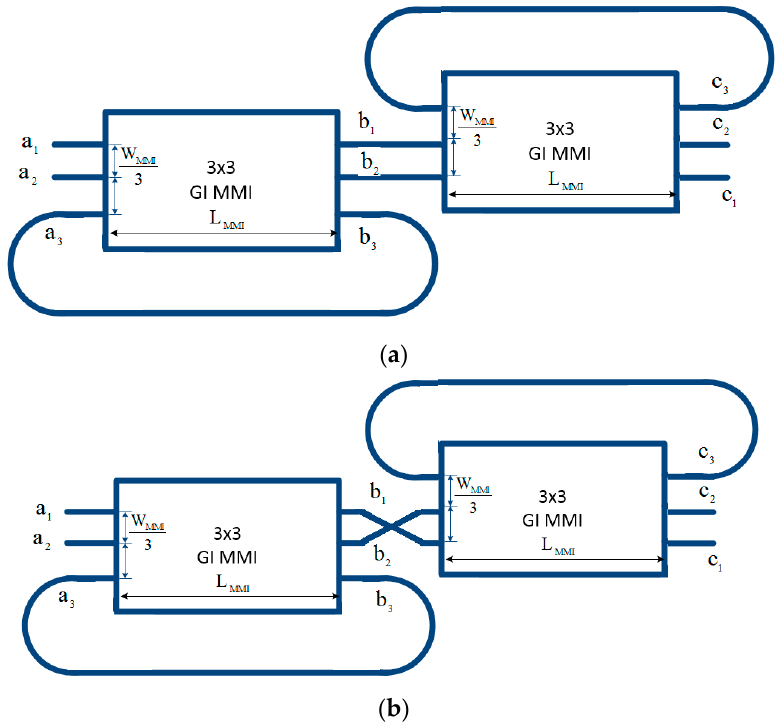
Figure 5. Coupled Fano resonances based on microring resonators based on 3 × 3 cascaded MMI couplers ( a ) cross without cross-connect and ( b ) bar with cross-connect made from 2 × 2 MMI coupler [42].